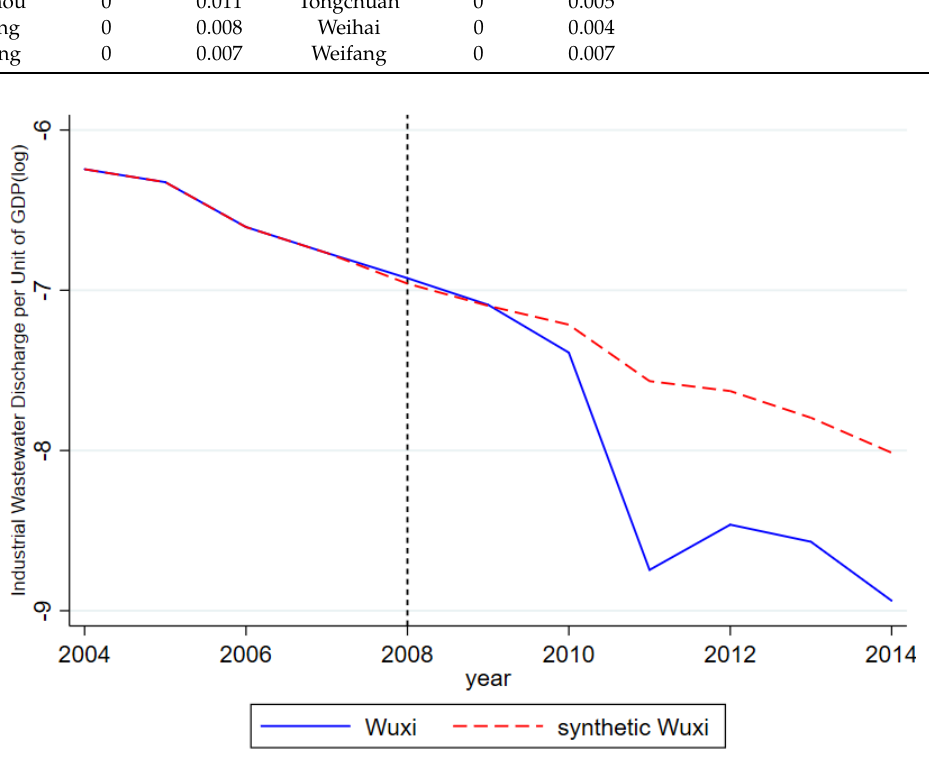
Figure 4. Policy E ff ects of Wuxi and Synthetic Figure 4. Policy Effects of Wuxi and Synthetic Wuxi.